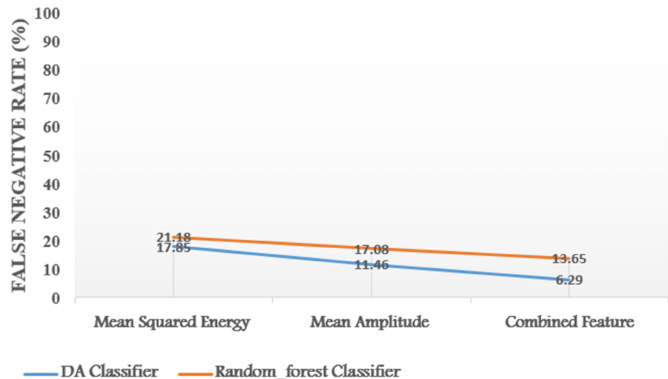
Figure 11. Effect of Feature kind on FNR values for different classifiers.